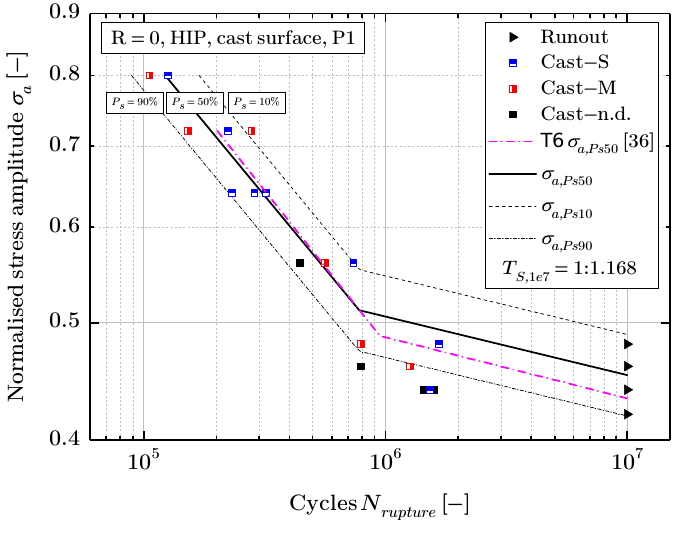
Figure 5. Normalised S/N-curve of the specimen series HIP